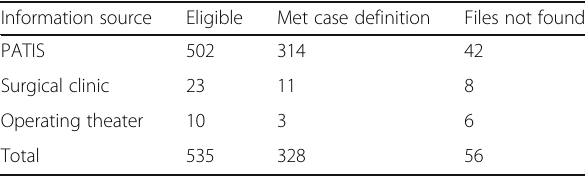
sources of data over the period 2006 to 2013 Information